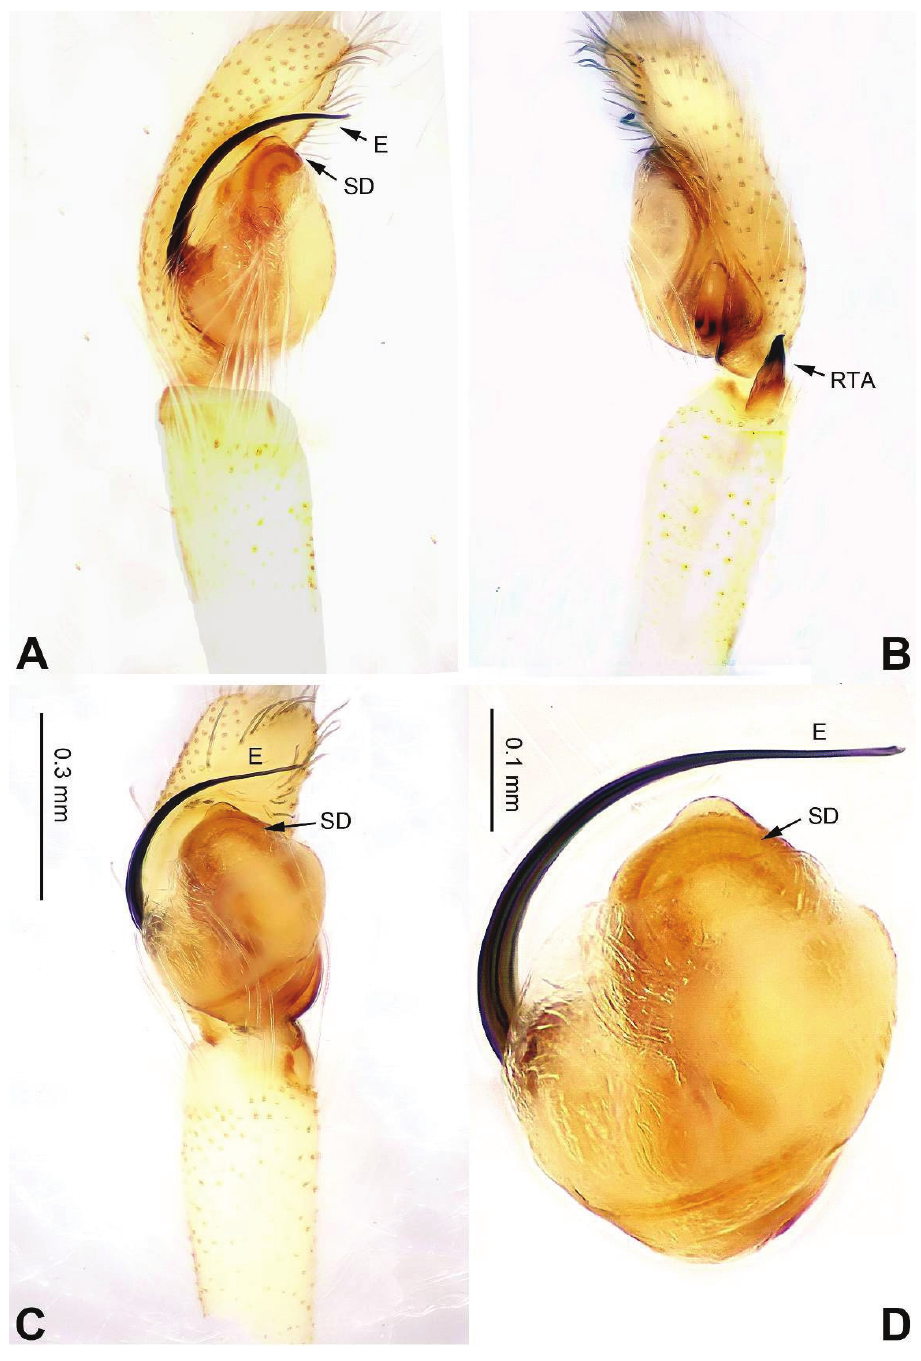
Figure 19. Palp of Cosmophasis xiaolonghaensis sp. n., male holotype. A prolateral B retrolateral C ventral D bulb, ventral. Scale bar equal for A–C